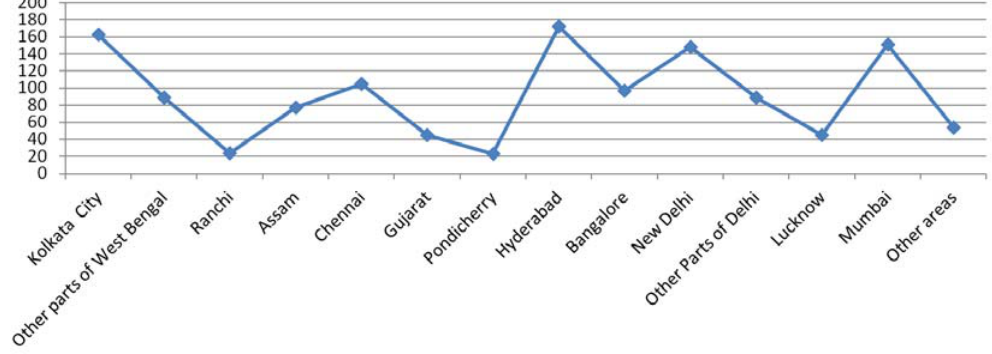
Fig. 3. Popular destinations in India for Bangladesh medical tourists Source: developed for this research.